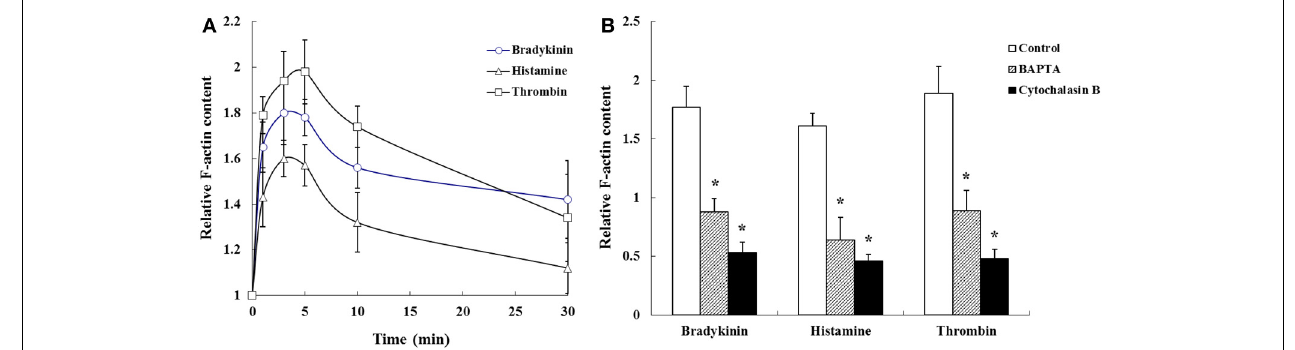
and thrombin (10 U) induced F-actin content. Values are means ± SD of 3 separate experiments. ∗ P < 0 . 05, significant difference from each